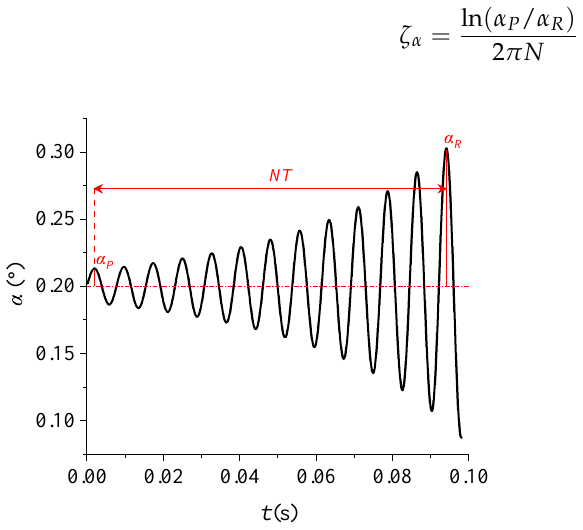
Figure 5. The definition of the damping ratio of the self-excited